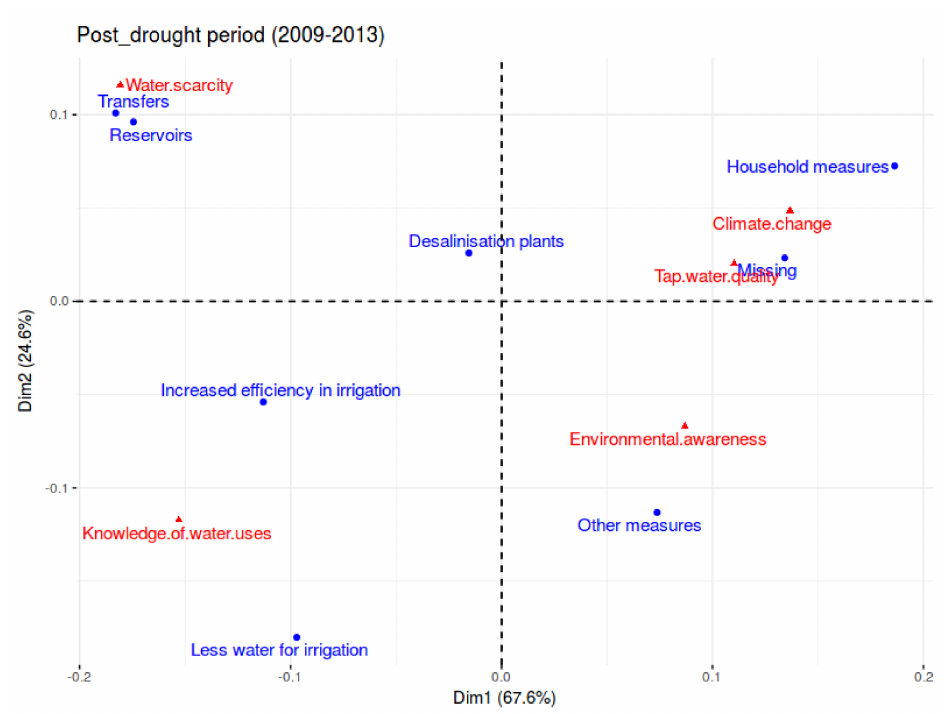
Figure 5. Correspondence analysis context variables and public preferences concerning water management policies in the post-drought period (2009–2013). Source: Authors’ own after EBA 2004–2013